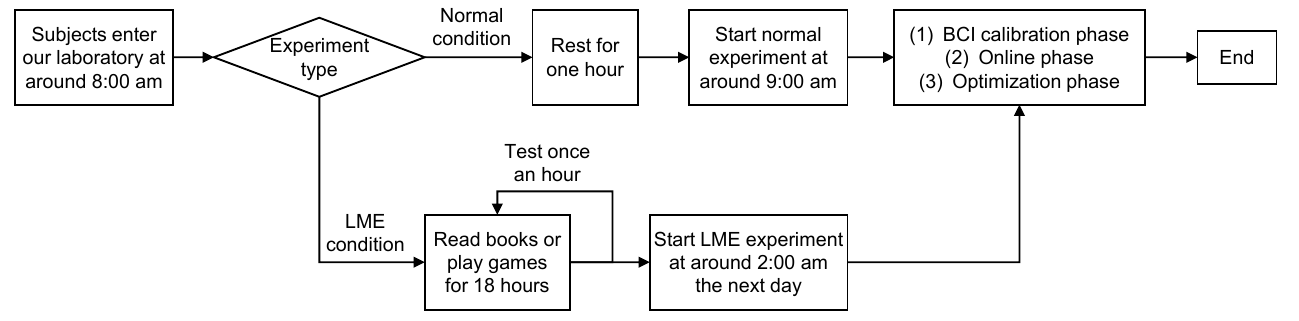
Figure 3. Illustration of our experiment design.